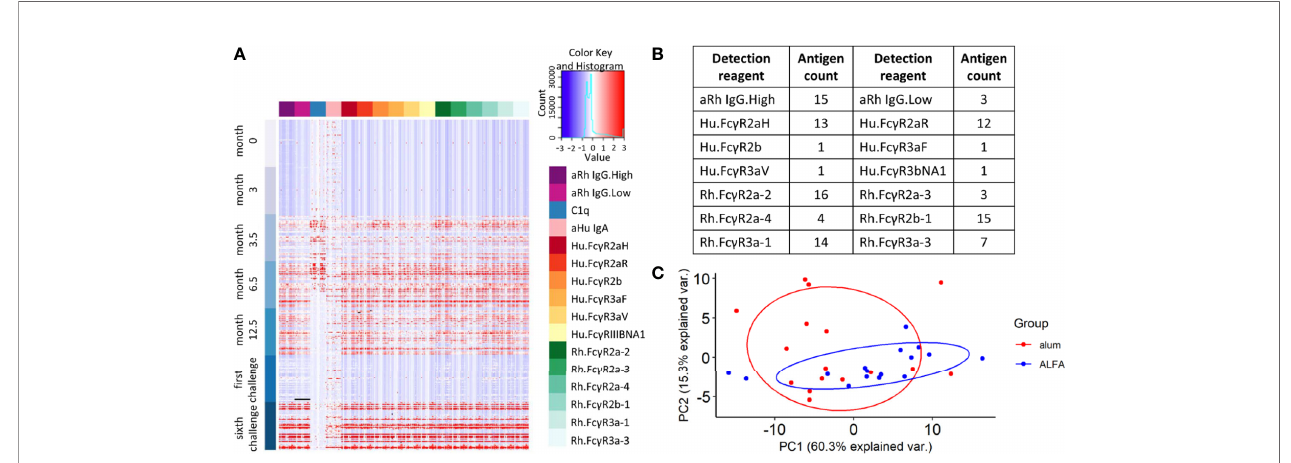
FIGURE 2 | Vaccine-elicited and Fc-mediated effector function. (A) Heat map for all Fc array measurements performed on all 48 study animals (rows) at each study time point by HIV-1 Env antigen and immune features (columns). (B) Fc features of vaccine-elicited immune responses at 12.5 months post-vaccination. (C) Principal component analysis on vaccine-elicited immune responses at 12.5 months post-vaccination by active vaccine